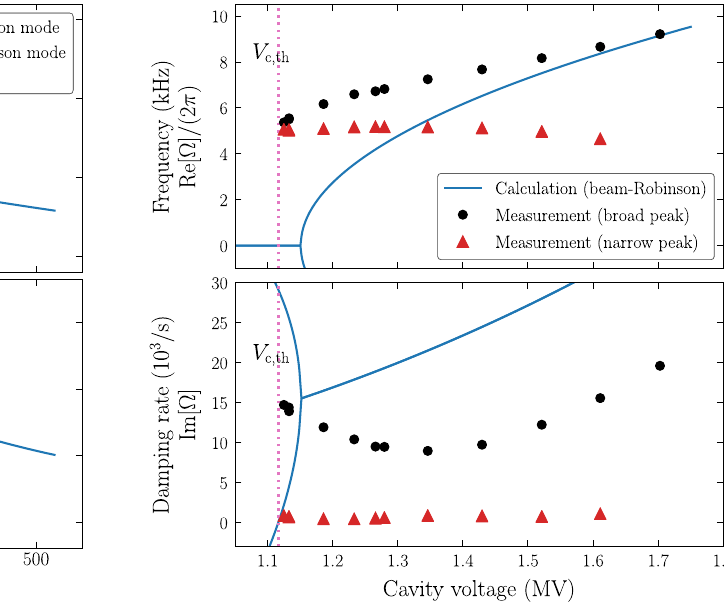
FIG. 12. Coherent frequencies (upper graph) and damping rates (lower graph) as functions of the average beam current. The cavity voltage was 1.70 MV. Closed circles indicate the data obtained by fitting the measured traces. The error bars were determined by convoluting the fitting error and resolution bandwidth of the spectrum analyzer. The solid lines indicate the numerical solutions of Eq. (1) at the cavity voltage of 1.70 MV. Note that the angular frequency was divided by 2 π in the upper graph to indicate the real frequency.